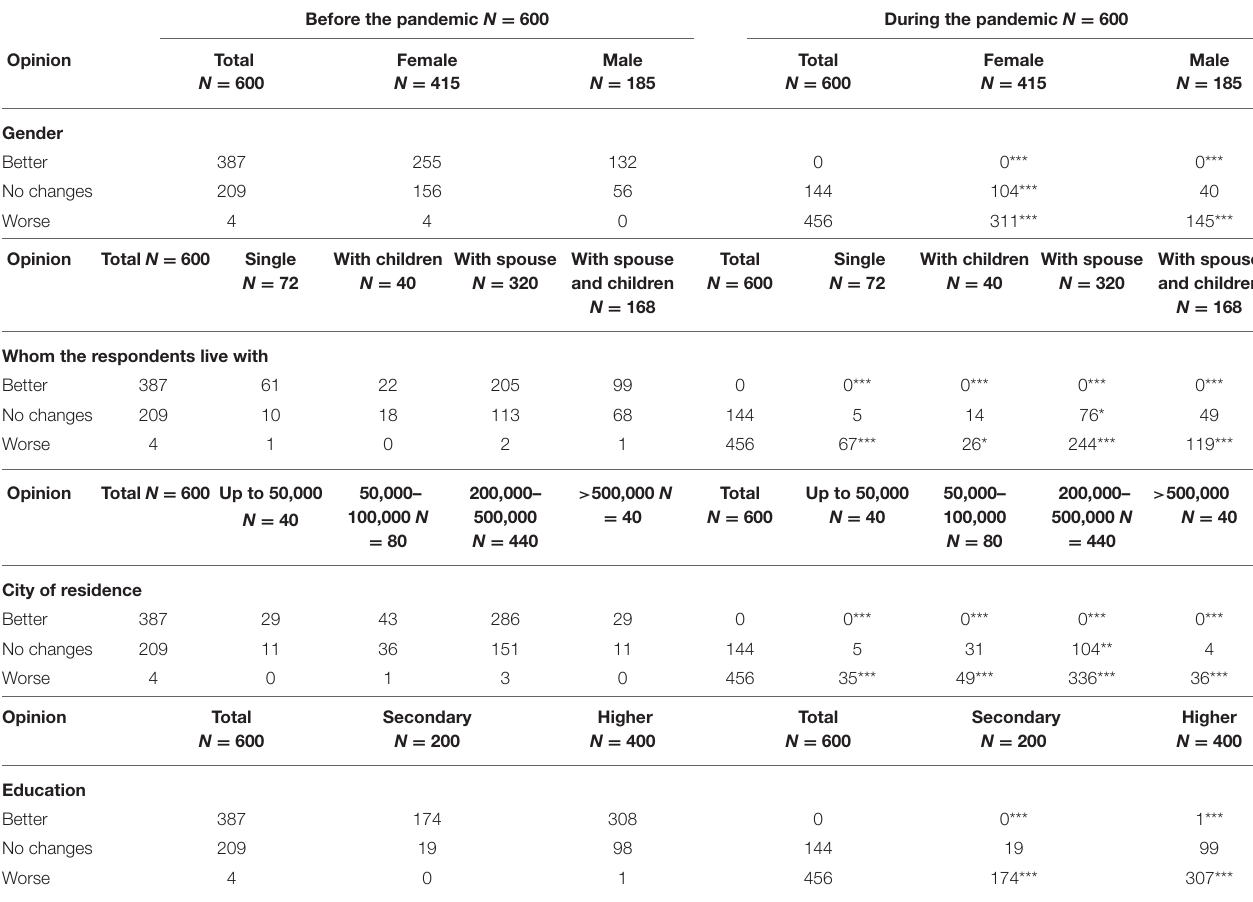
TABLE 2 | Respondents’ assessment of the health status of their families – before and during the pandemic. Before the pandemic N = 600 During the pandemic N =